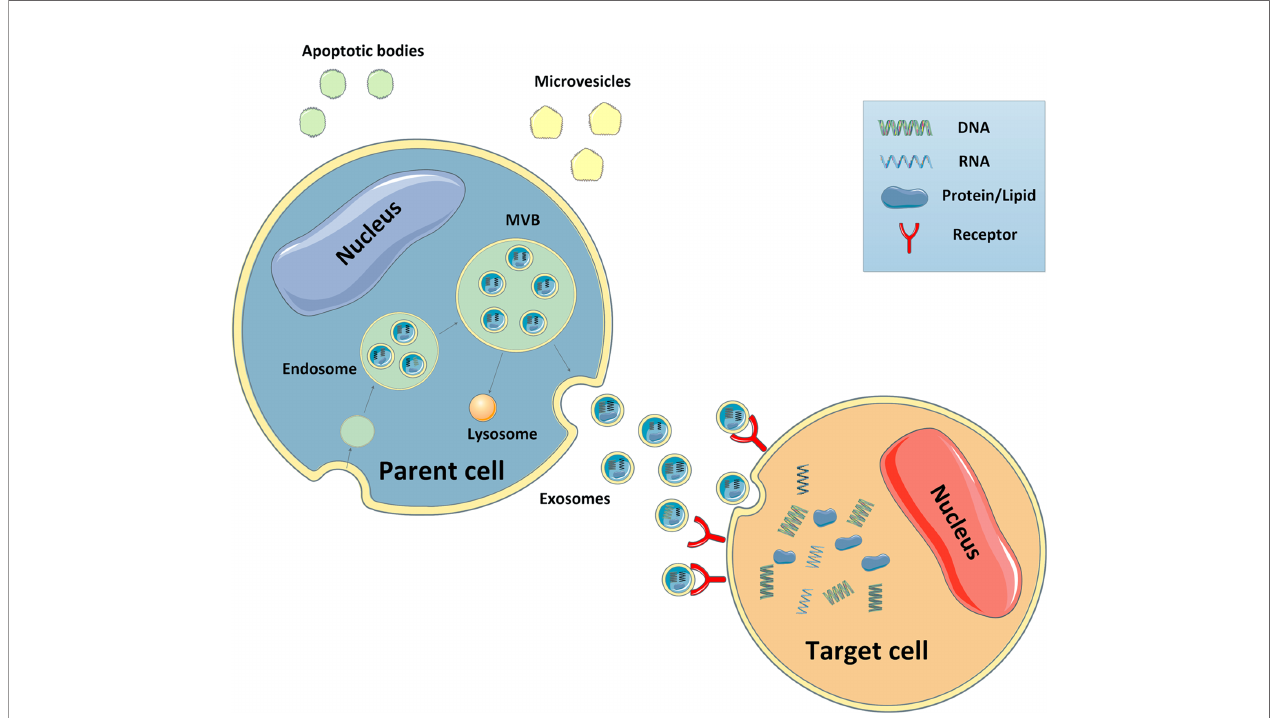
FIGURE 2 | Biogenesis of EVs and target cell interactions. Microvesicles are generated by plasma membrane budding. Apoptotic bodies are formed by outward budding of the plasma membrane of apoptotic cells. Exosomes are generated within the cells through the endosomal pathway. The cellular contents form intraluminal vesicles which aggregate to form larger vesicles known as MVBs. Some of these MVBs then fuse with lysosomes to degrade cellular components, whereas others fuse with the membrane and are secreted into the extracellular milieu. Subsequently, these exosomes travel to neighboring and distant organs and impact the cellular function of recipient